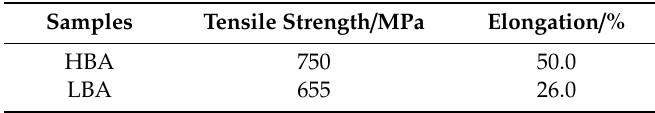
Table 3. 650 ◦ C tensile properties of the investigated alloys.